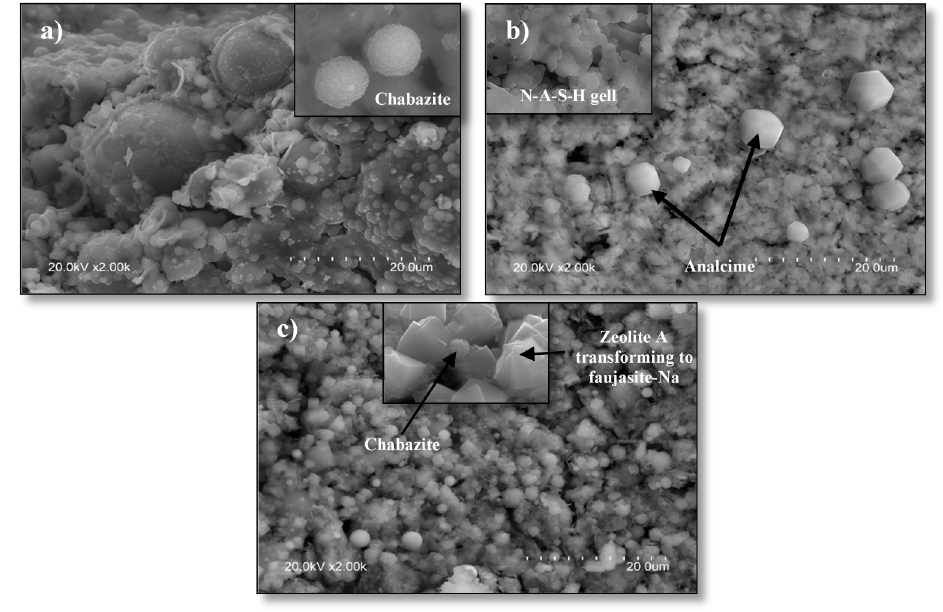
Figure 7. Porous surface-studied pAAM by SEM with magnification ×2000 : ( a ) FA_0, ( b ) MK_0, ( c ) FA + MK_0.